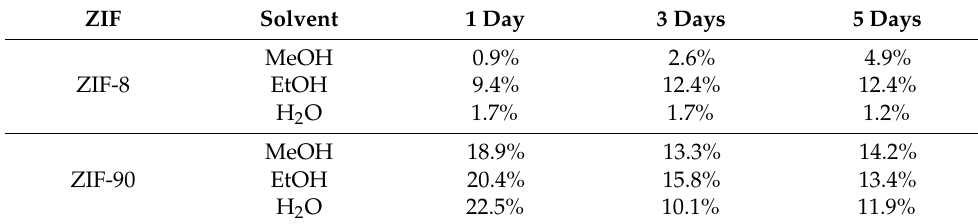
Table 4. % of solvent adsorbed for ZIF-8 and ZIF-90 after soaking for 1 day, 3 days and 5 days. ZIF Solvent